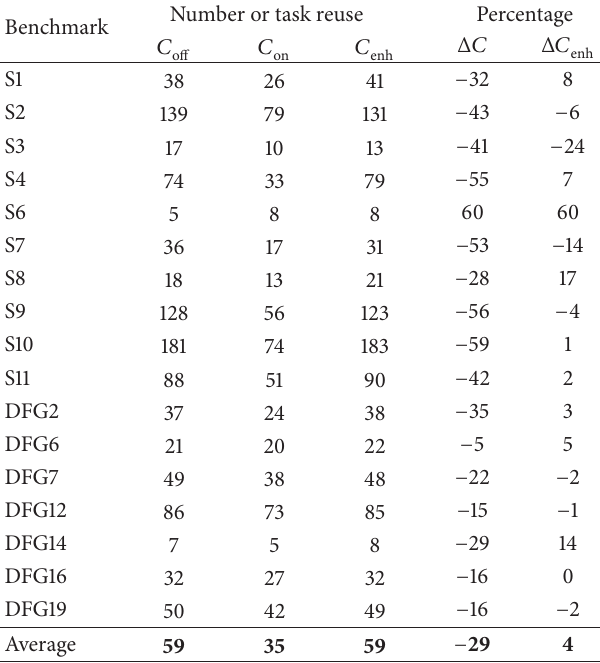
Table5:Comparisonofschedulersbasedonnumberofreusedtasks (before learning).